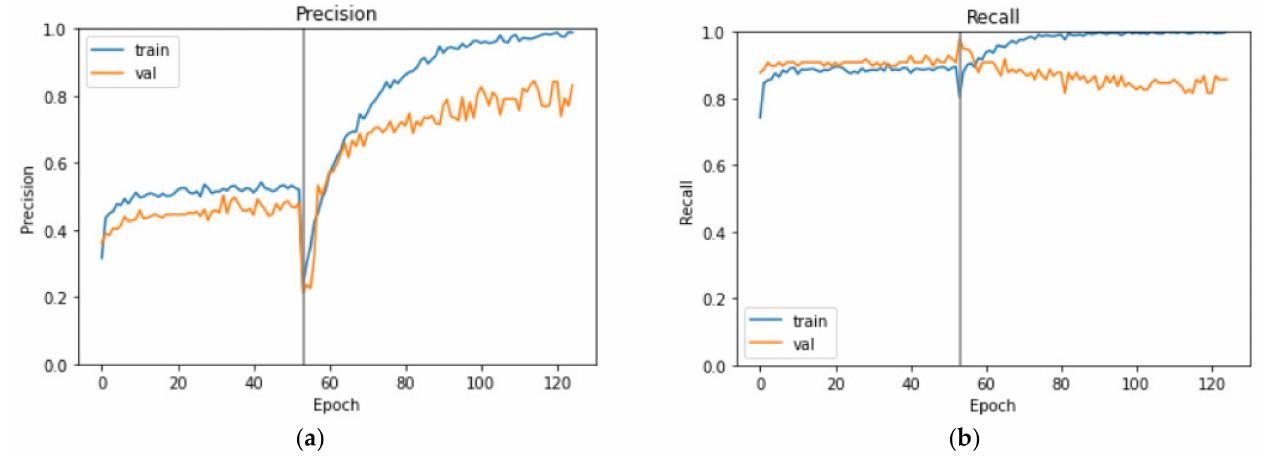
Figure 8. Evaluation metrics over each learning epoch ( a ) precision; ( b )